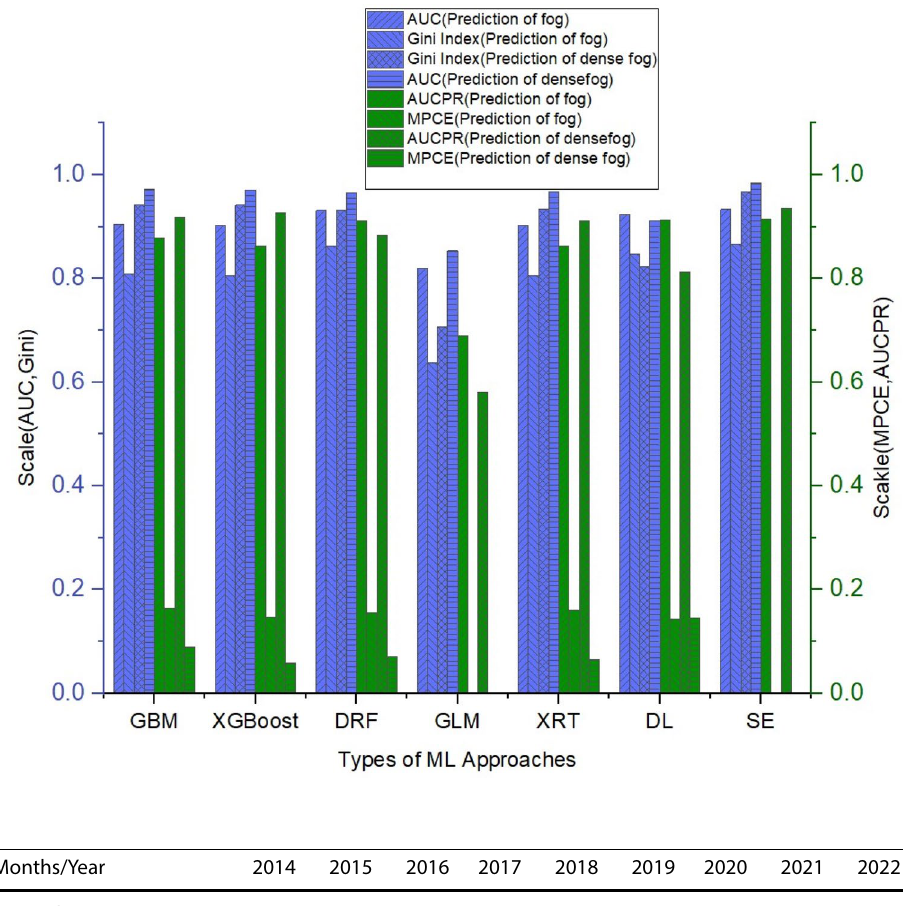
Table 3 Mean no. of hours of Fog (Surface Visibility ≤ 1000 m) and Dense Fog (Surface Visibility ≤ 200 m) events (In hours) for the JPNI Airport,